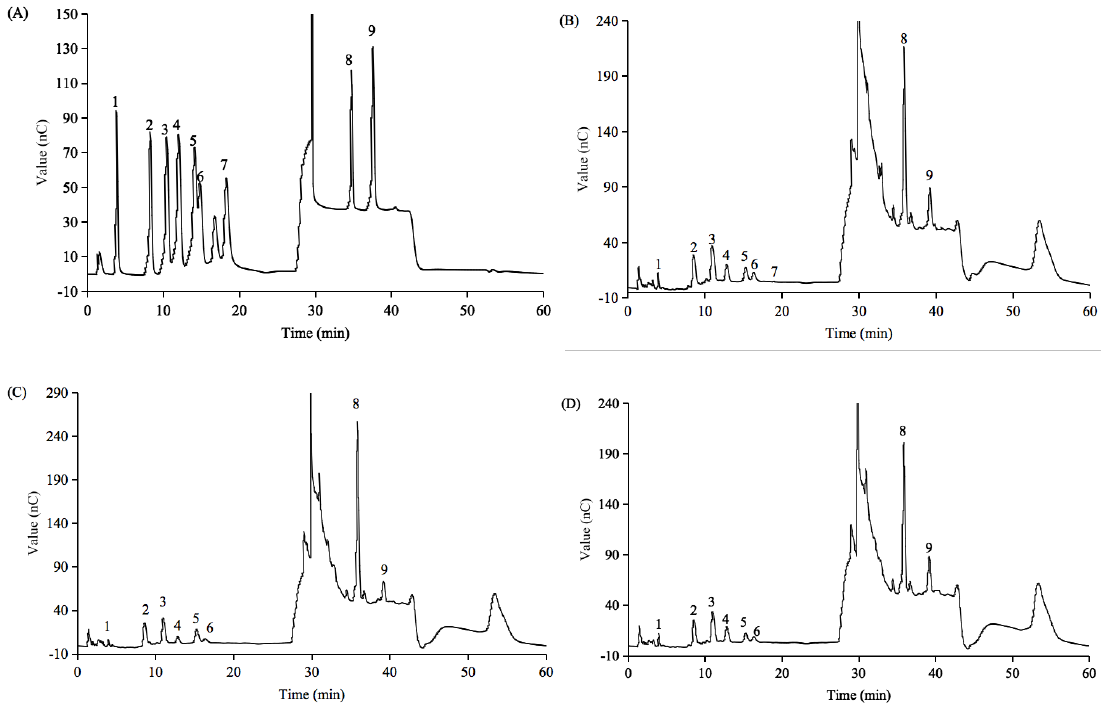
Figure 2. The ion chromatography (IC) chromatograms of standard monosaccharides. 1, fucose; 2, arabinose; 3, galactose; 4, glucose, 5, xylose; 6, mannose; 7, ribose; 8, galacturonic acid; and 9, glucuronic acid ( A ); The IC chromatograms of PFP2 ( B ), PFP3 ( C ), and PFP4 ( D ).